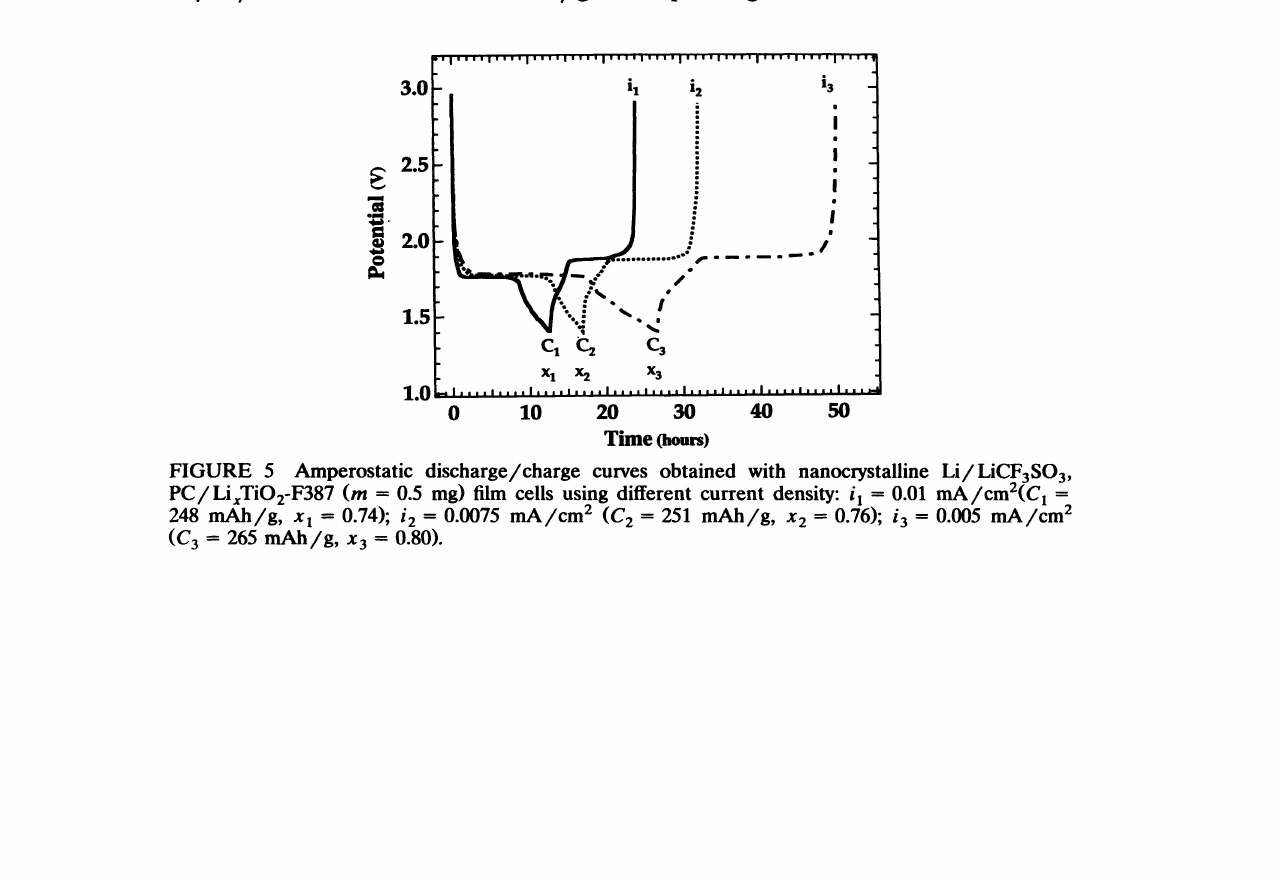
FIGURE 4 Amperostatic discharge/charge curves obtained with a nanocrystalline Li/LiCF3SO PC/LixTiO2-F387 film cell, current density was 0.01 mA/cm 2.